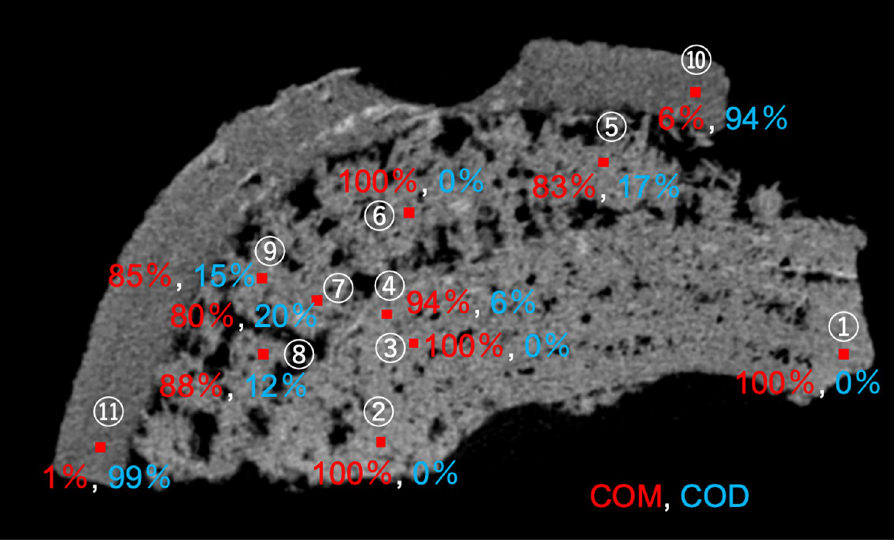
Fig 5. A microfocus X-ray CT image. Eleven analysis points are indicated with red solid squares and numbers . The analyzed results (the ratio of COM and COD in the 50-mm 2 squares) are also shown. Red numbers : the COM ratio. Blue numbers : the COD ratio for each area.